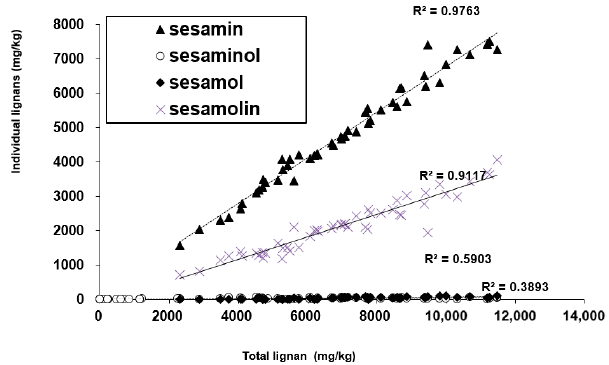
Figure 2. Correlation between total lignans and individual lignans in sesame seeds and sesame oil.